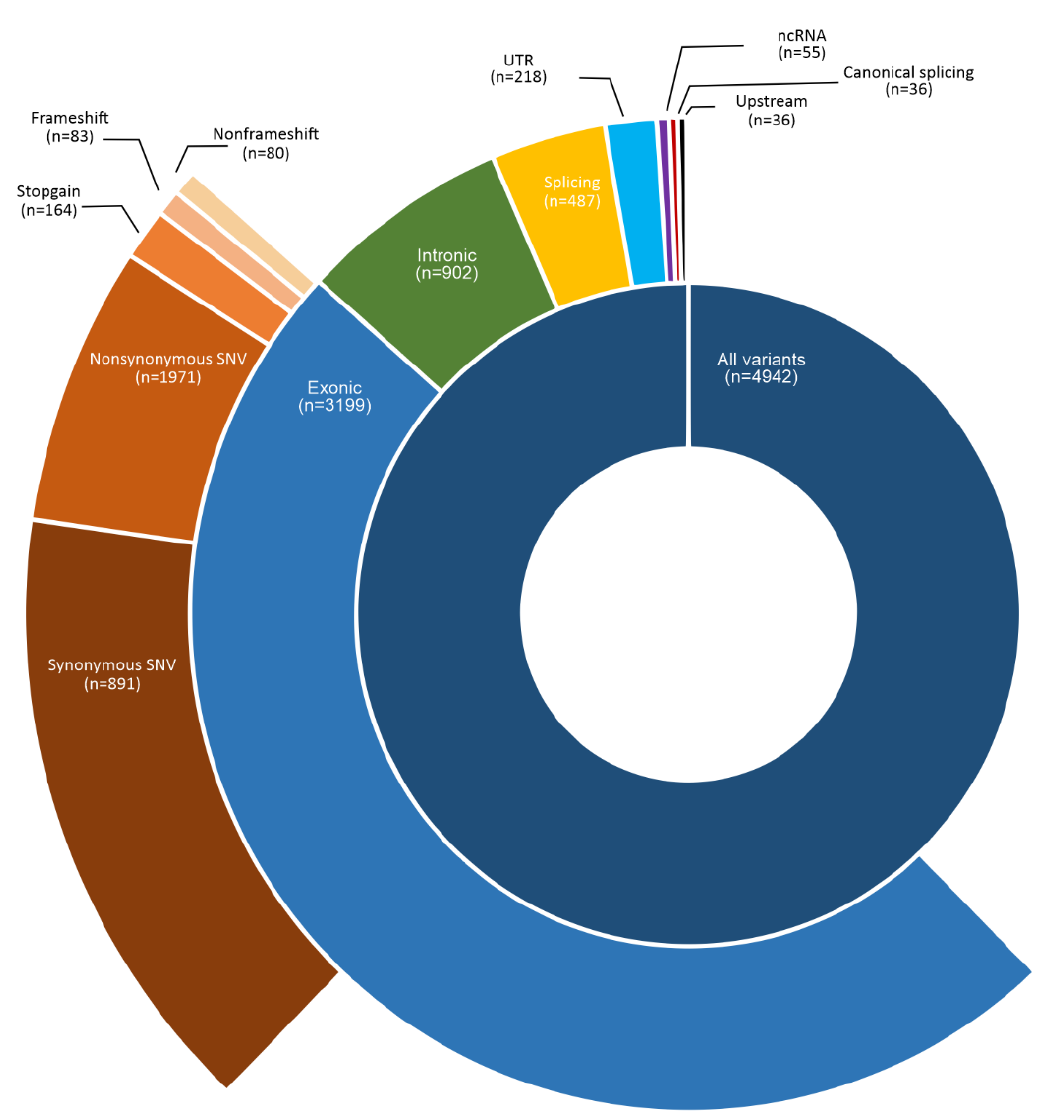
Figure 1. Somatic variants identified in human papillomavirus-associated penile squamous cell carcinomas from Latin American patients. The full circle in darker blue represents the total number of variants identified in 3872 genes. The semicircle in the middle represents the number of variants identified according to the gene’s location: exonic (2654 genes), intronic (850 genes), splicing (466 genes), UTR (214 genes), ncRNA (48 genes), canonical splicing (35 genes), and upstream (28 genes). The outer semicircle shows the types of variants identified in the exonic region: synonymous SNV (853 genes), non-synonymous SNV (1742 genes), stop-gain (149 genes), frameshift (73 genes), and non-frameshift (77 genes).